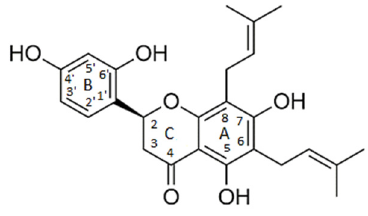
Figure 5. Kushenol E. Figure 5. Kushenol